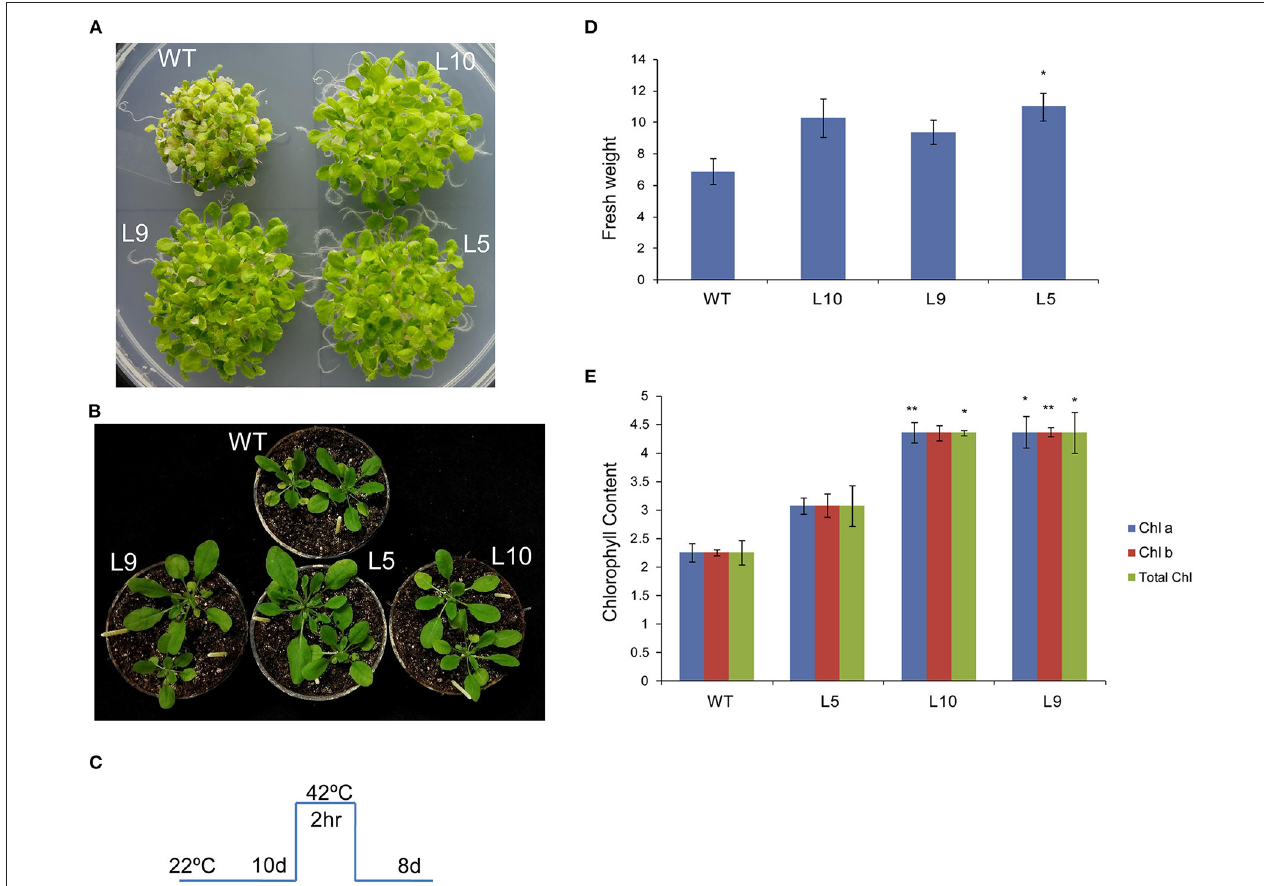
FIGURE 6 | Overexpression of TaOBF1-5B in Arabidopsis thaliana promoted better growth and more chlorophyll levels under basal heat stress conditions. (A,B) Photographs showing thermotolerance in Arabidopsis TaOBF1-5B-overexpression lines. (C) Depiction of stress regime. (D,E) Graphs representing fresh weight chlorophyll content, respectively. Asterisks indicates statistically significant difference. (Student t -test: * p ≤ 0.05; ** p ≤ 0.01).